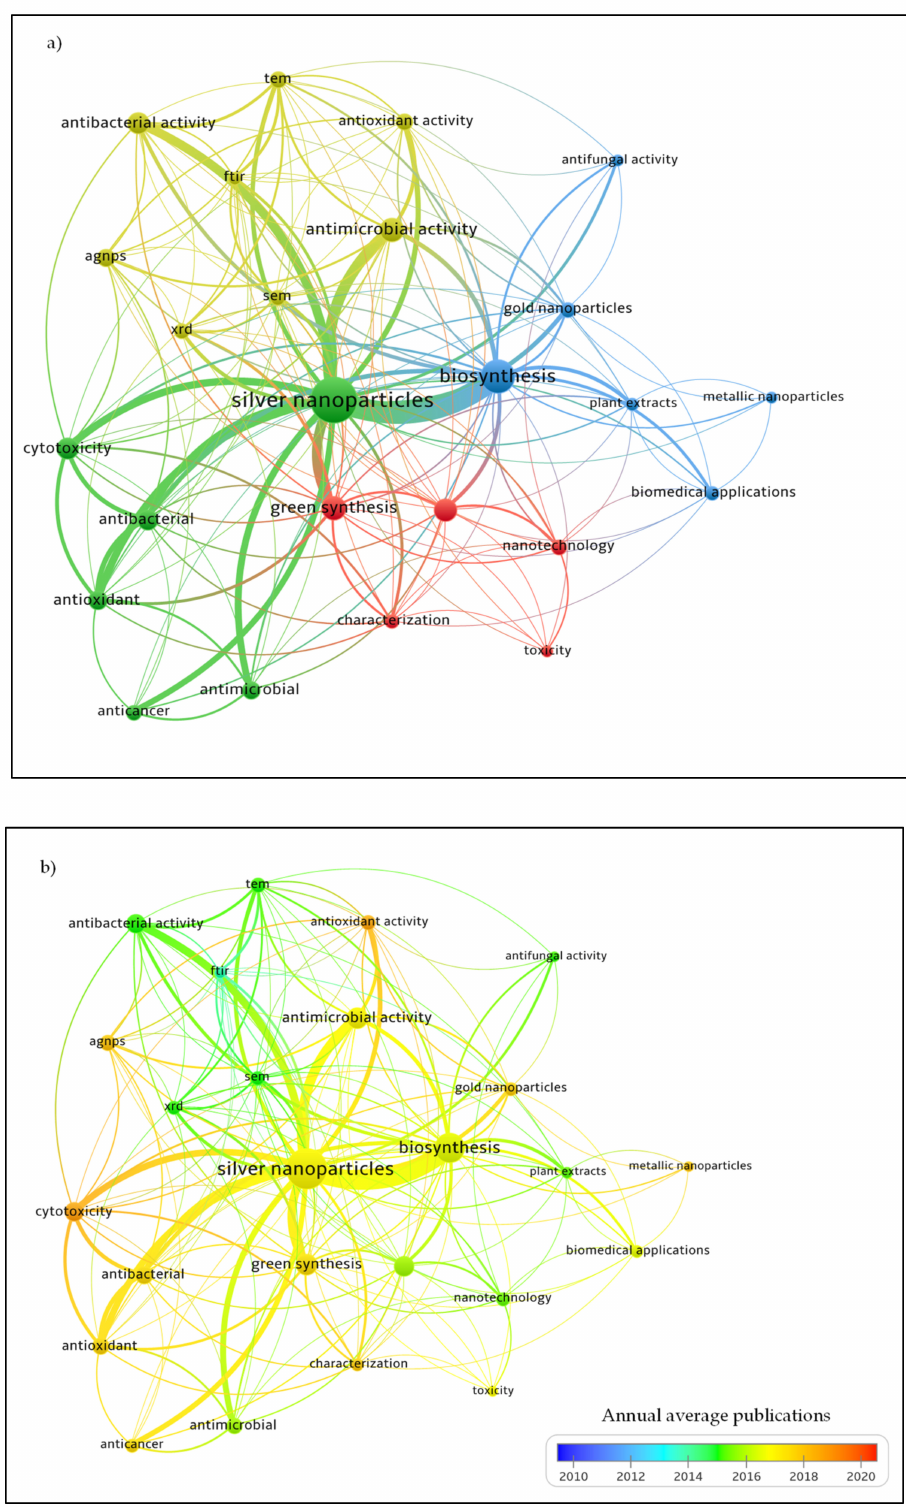
Figure 3. Research trend clusters mapping. ( a ) Network visualization of author keywords co- occurrences ( b ) Network visualization of author’s keywords cluster analysis across the annual average publications on the biomedical applications of AgNPs published between 2010 and 2020. Abbreviations: Fourier-transform infrared spectroscopy (FTIR), Transmission electron microscopy (TEM), Scanning electron microscopy (SEM), and X-ray diffraction